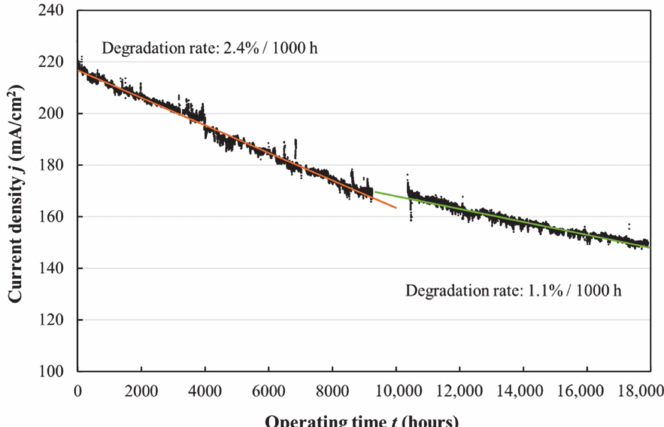
Figure 3. Dependence of current density on time of the SOFC durability test measured at T = 650 ◦ C and at E = 0.85 V. A slow change of degradation rate can be observed starting from around the 9000 h